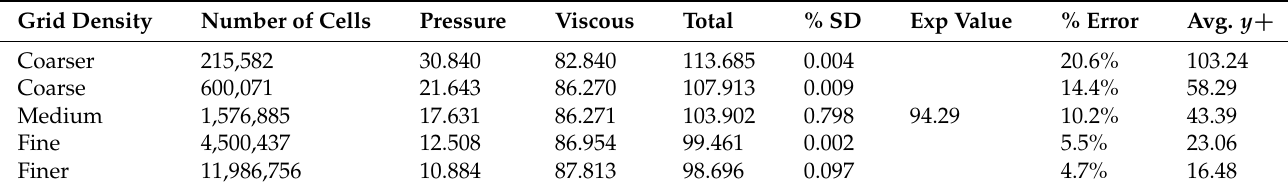
Figure 9. Convergence of forces on SUBOFF in CFD simulations for H / D = 5.4 and Fr = 0.466. Table 7. Average and standard deviation of force components vs grid density for SUB-OFF submarine at Fr = 0.466 and H / D = 5.4.